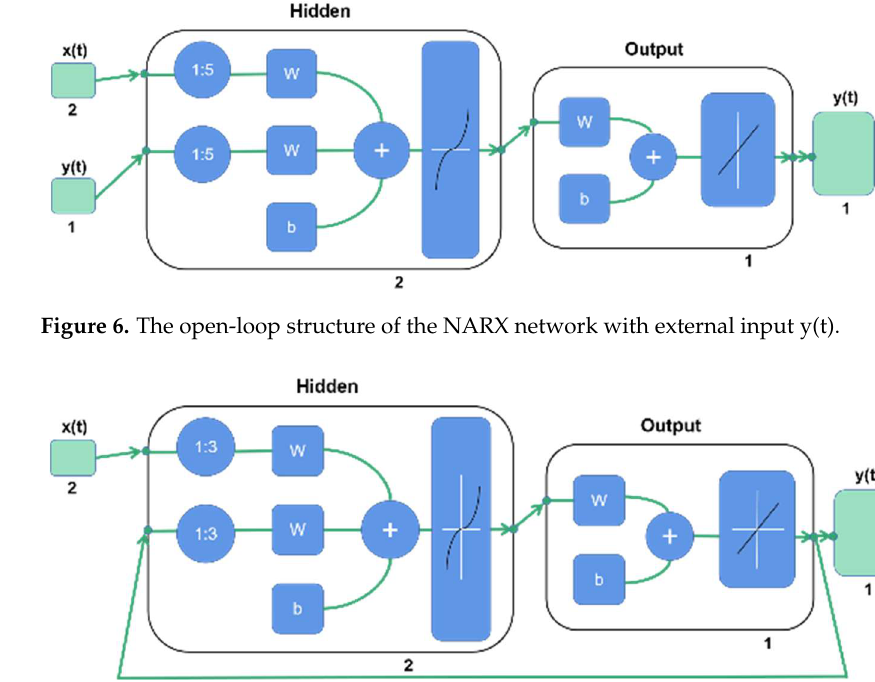
Figure 7. The closed-loop structure of the NARX network with no external input y(t).